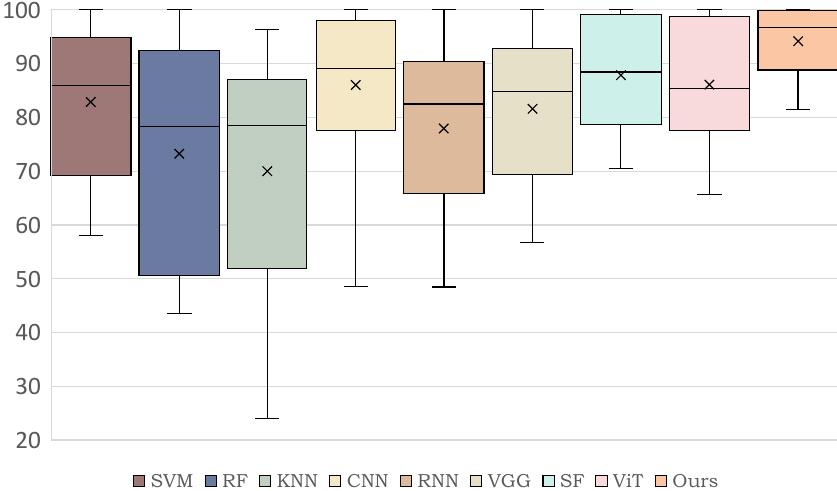
Figure 5. Box plot classification analysis of each algorithm on Indian